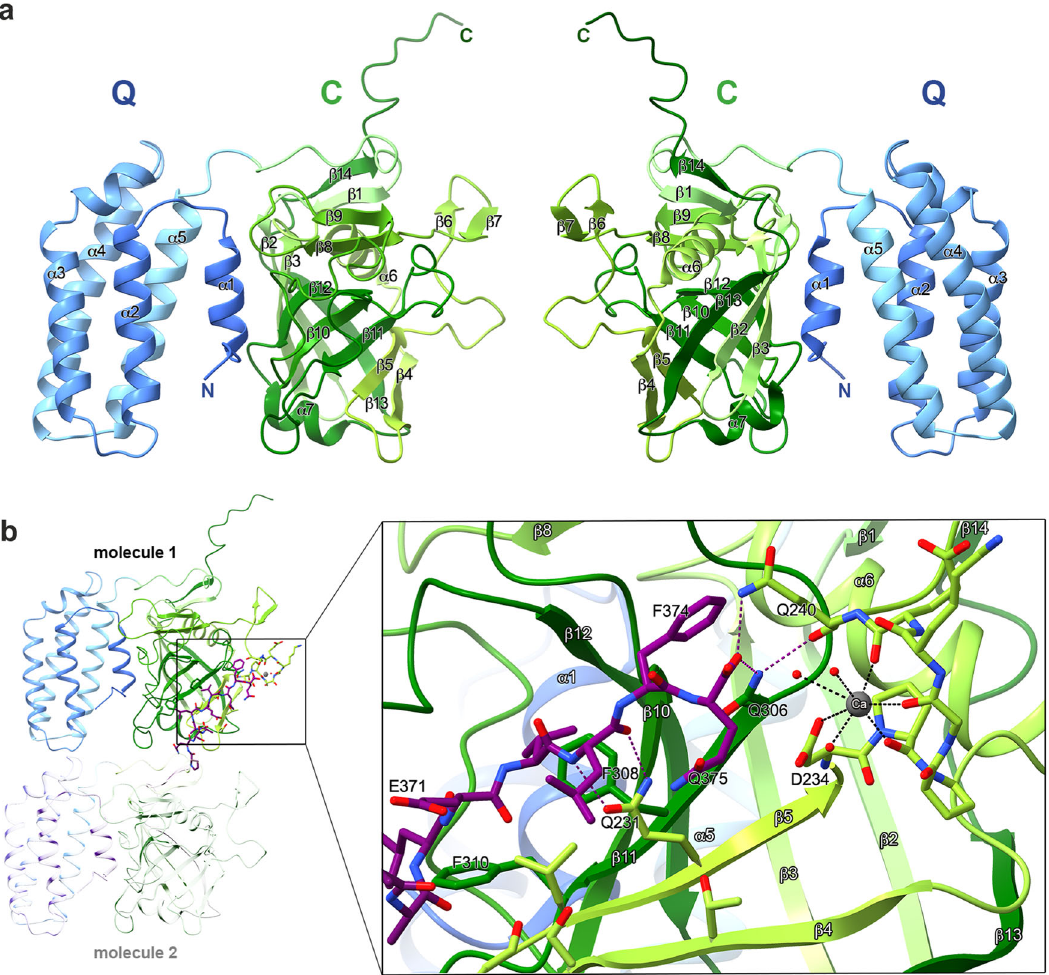
Fig. 6 Overall structure of ana Cyp40. a Ribbon presentation of ana Cyp40 from two orientations related to each other by a 180° vertical rotation. The N-terminal four-helix bundle (Q-domain) is shown in blue and the cyclophilin domain (C-domain) is shown in green colors. The two domains are linked by a fl exible loop. The interaction between the domains is mediated by the N-terminal helix ( α 1). The cyclophilin domain is formed by a distorted β -barrel with eight β -strands ( β 2 – 5 and β 10 – 13). The β -barrel is fl anked on one side by helix α 6 and the remaining β -strands and on the other side by helix α 7. The N- and C-termini are indicated. b The intermolecular interactions between two symmetry-related ana Cyp40 molecules are shown on the left side. The interaction is mediated by the last seven C-terminal residues shown in purple. The boxed region is magni fi ed on the right side and shows the interactions of the C-terminal peptide with the potential substrate binding site on the outer surface of the β -barrel. The metal at the site within close proximity to the C-terminus of the symmetry-related monomer was interpreted as heptagonal coordinated calcium ion (Ca 2 + ) that obviously is part of the active site of ana